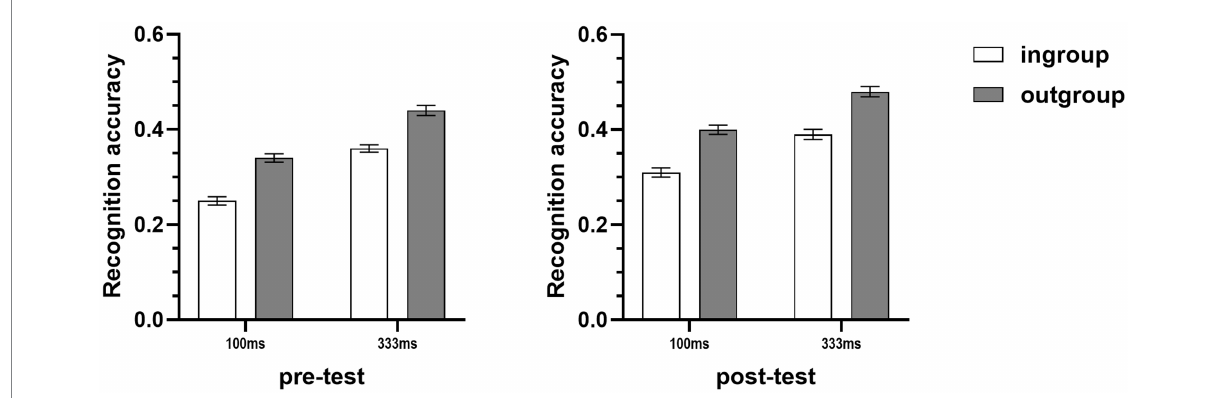
FIGURE 3 Mean recognition accuracies of micro-expressions of ingroup and outgroup members collapsed across two METT training conditions (Study 1B). Error bars represent standard